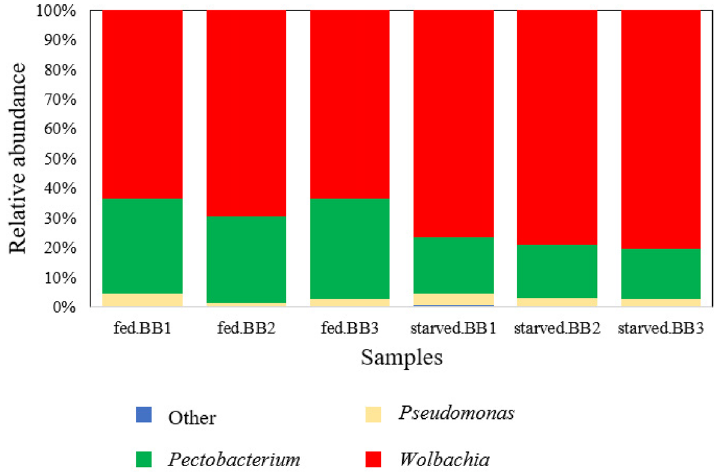
Figure 6. The relative abundance of bacteria genera in each sample from blood-fed bed bugs (start from left, fed.BB1–fed.BB3) and starved bed bugs (starved.BB1–starved.BB3).